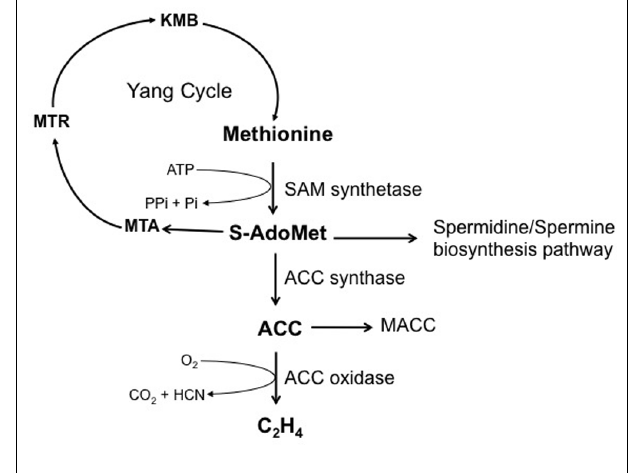
FIGURE 3 | Ethylene biosynthesis pathway. S -adenosyl-methionine ( S -AdoMet) is synthesized from the methionine by the S -adenosyl-methionine synthetase (SAM synthetase) with one ATP molecule expensed per S -AdoMet synthesized. S -AdoMet is then converted to 1-aminocyclopropane-1-carboxylic acid (ACC) by ACC synthase, 5 (cid:2) -methylthioadenosine (MTA) being a by-product. MTA is recycled to methionine by successive enzymatic reactions involving various intermediates (MTR, 5-methylthioribose; KMB, 2-keto-4-methylthiobutyrate), which constitute the methionine (Yang) cycle. S -AdoMet is also the precursor of the spermidine/spermine biosynthesis pathway. Ethylene production is catalyzed by the ACC oxidase using ACC as substrate, and generates carbon dioxide and hydrogen cyanide. Malonylation of ACC to malonyl-ACC (MACC) reduces ACC content and consequently ethylene